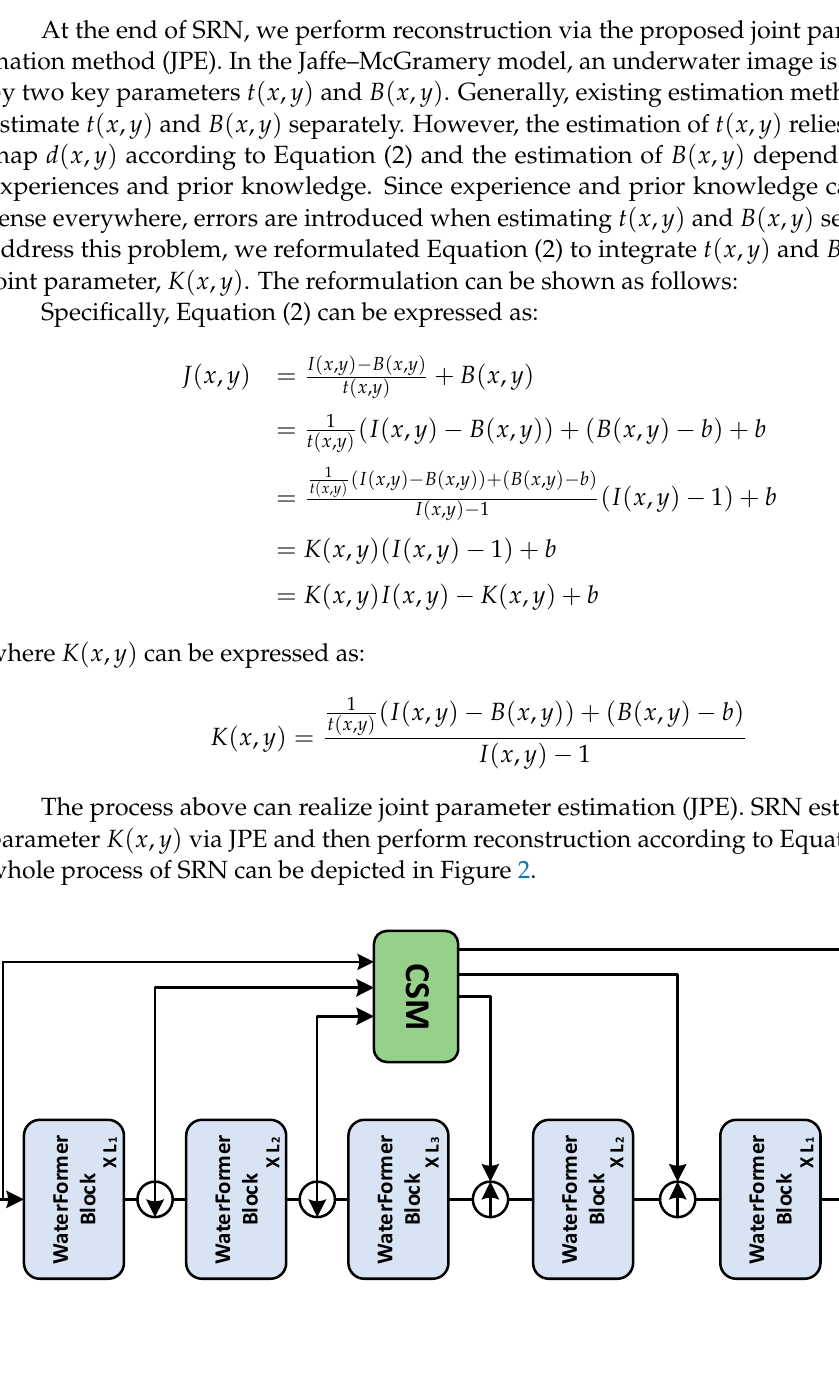
Figure 3. Visualization of the joint parameter map. 3.1.2. Hard Enhancement Network The architecture of HEN is shown in Figure 4. HEN has a similar structure as SRN. HEN estimates the global residual